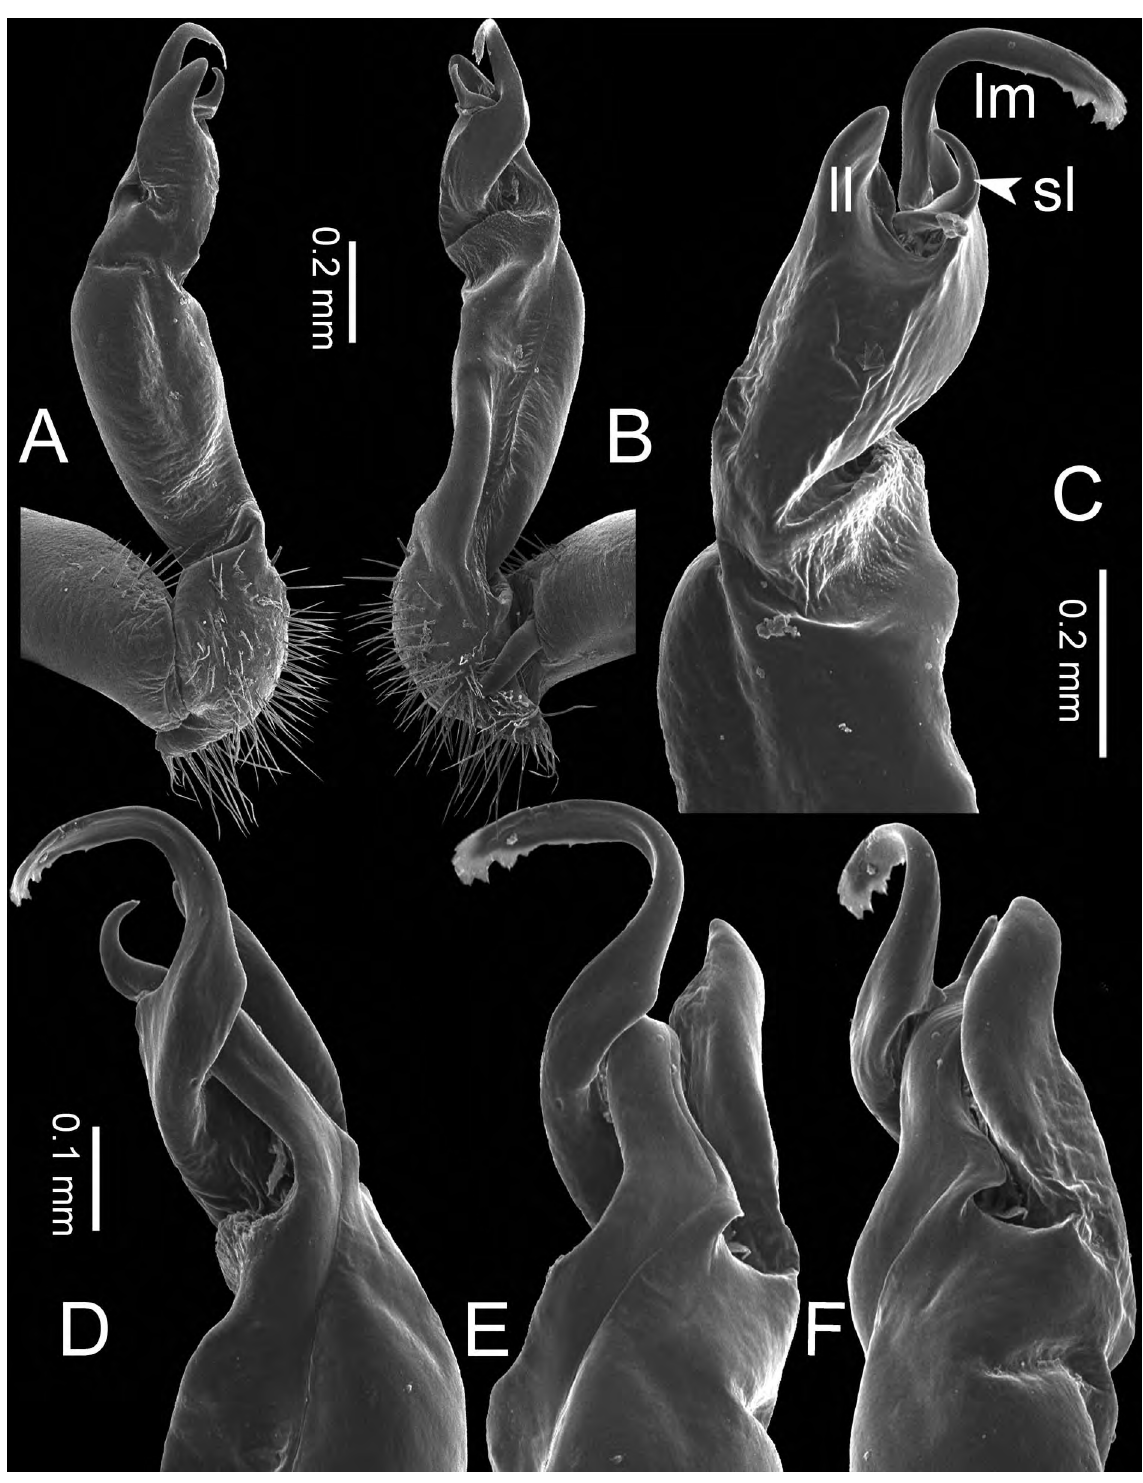
Fig. 16. Nagaxytes erecta Srisonchai, Enghoff & Panha gen. et sp. nov. (paratype, CUMZ- pxDGT00002), right gonopod. A . Lateral view. B . Mesal view. C . Ventral view. D , F . Subdorsal view. E . Dorsal